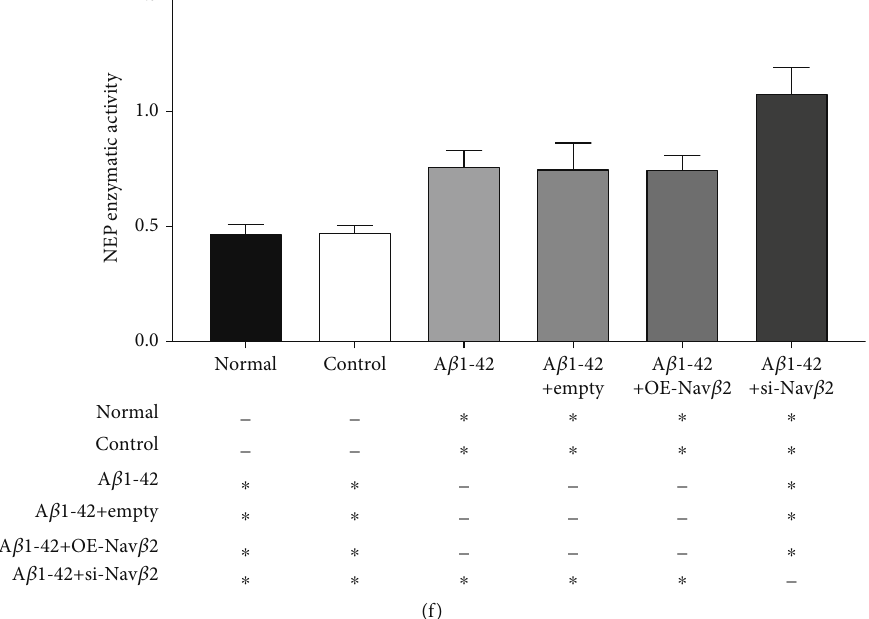
Figure 4: E ff ects of A β 1-42 and Nav β 2 on APP, BDNF, and NEP in A β 1-42-treated neurons. (a) Western blotting plots of Nav β 2, APP, BDNF, NEP, and GAPDH between each A β 1-42-induced primary neuron injury model group. (b – e) Quantitative images of Nav β 2, APP, BDNF, and NEP in hippocampus of each experimental groups (normal, control, A β 1-42, A β 1-42+empty, A β 1-42+OE-Nav β 2, and A β 1-42+si-Nav β 2). ∗ Versus two di ff erent treatment groups, P < 0 : 05 . # Compare the remaining treatment groups with the marker group, P < 0 : 05 . (f) Quantitative image of NEP enzymatic activity between each experimental group ( n = 7 ). ∗ Versus two di ff erent treatment groups, P < 0 : 05 . - Versus two di ff erent treatment groups, P > 0 : 05 . Empty: empty viral vector; OE: overexpression; si: small